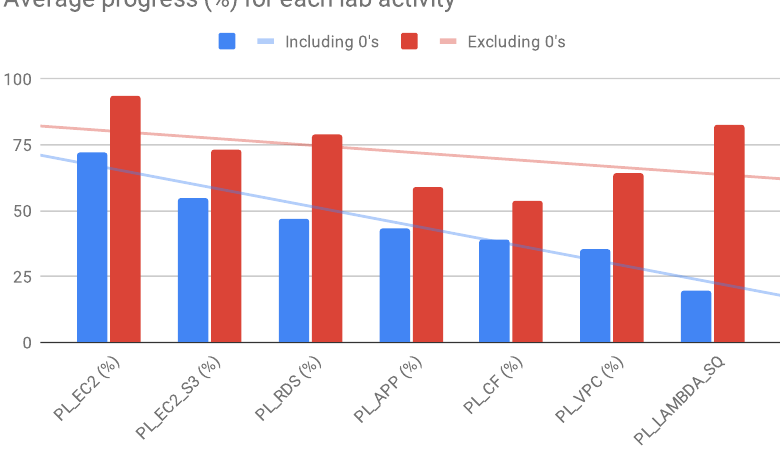
Figure 3. Average progress (percentage) for each lab activity across the student population ( N =